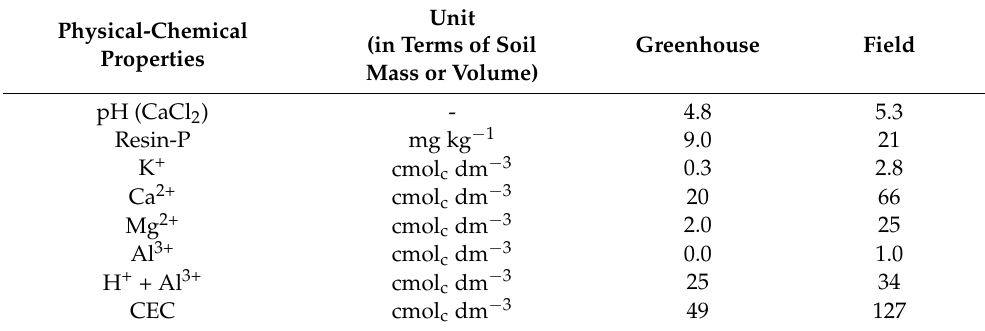
Table 6. Chemical (1) and physical (2) properties of soils used for the experiments in greenhouse and in field,